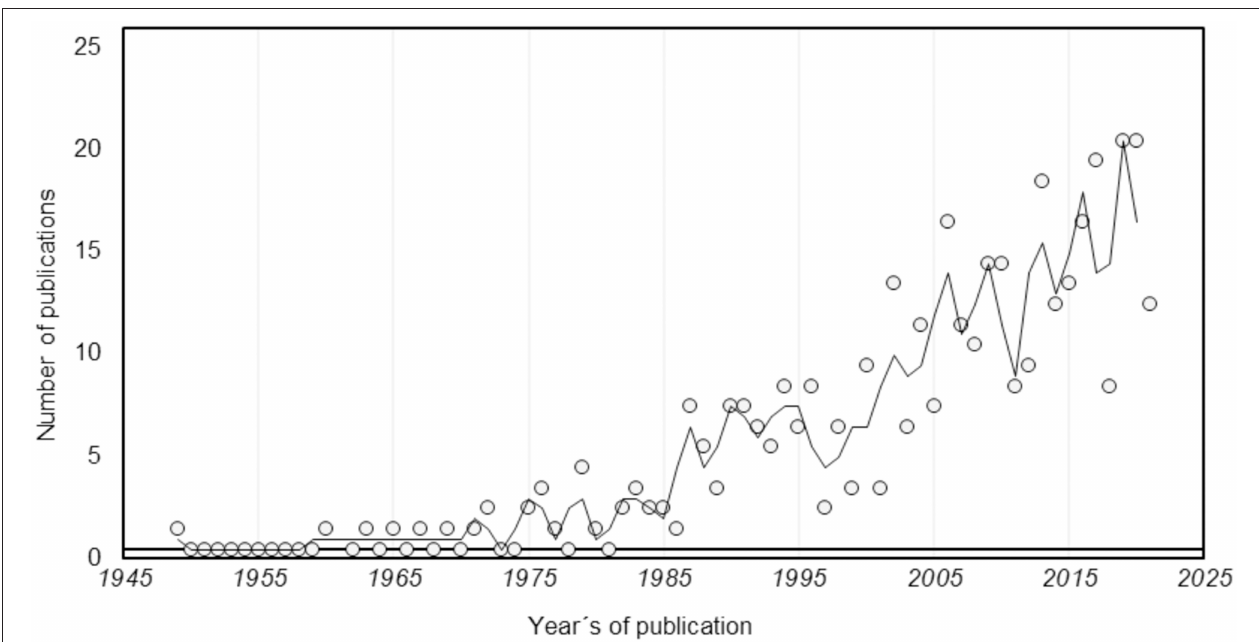
FIGURE 2 | Chronological evolution of scientific production in Stereotactic and Functional Neurosurgery in